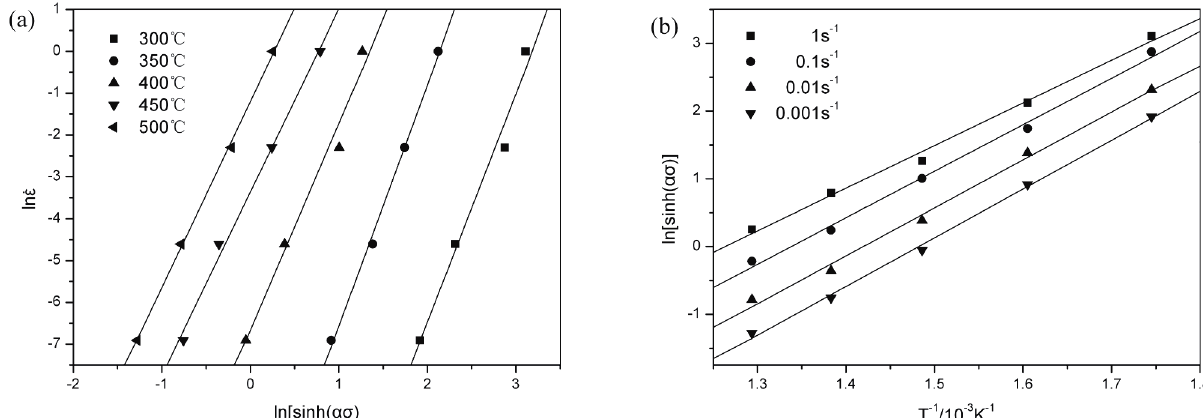
Fig. 3: Relationships between: (a) ln ε  – ln[sinh( ασ )]; (b) ln[sinh( ασ )] –